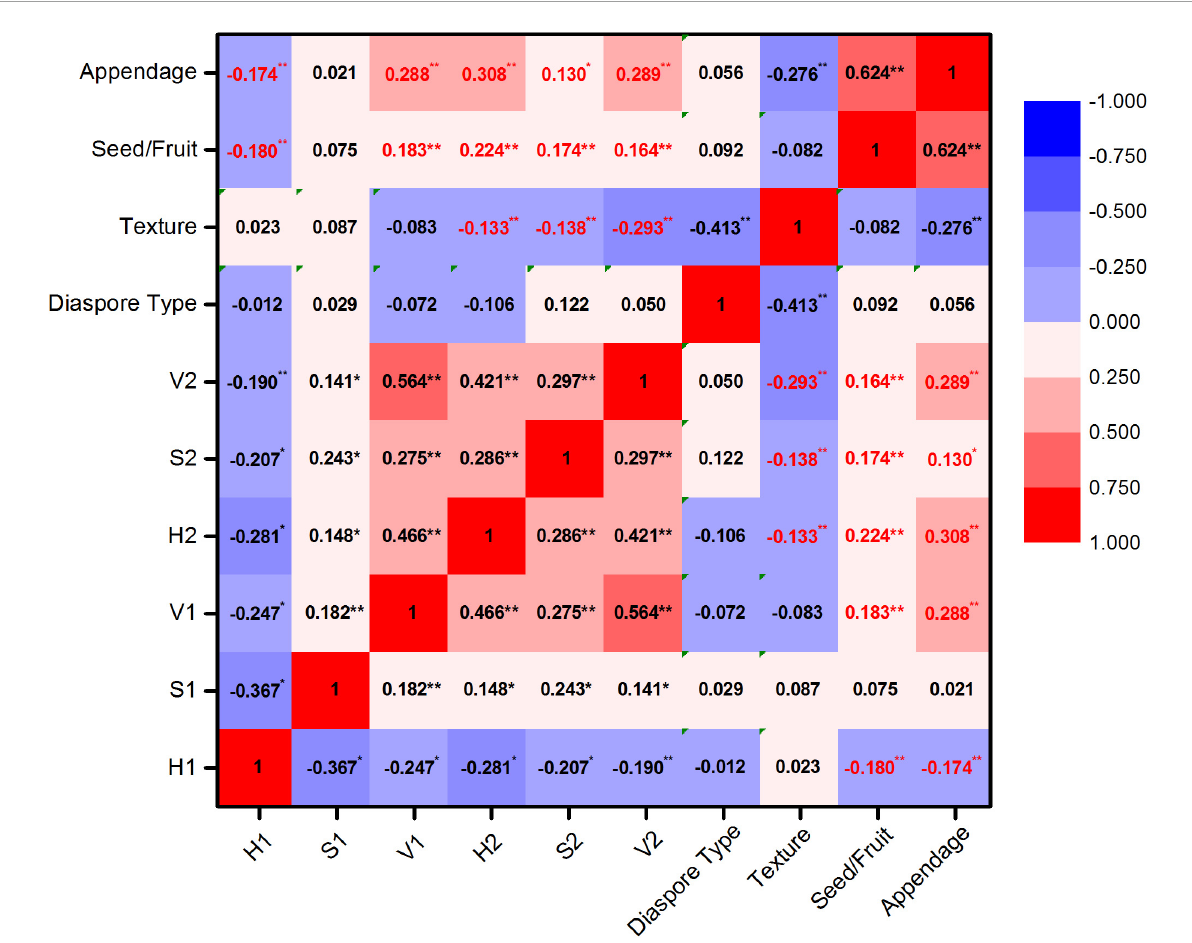
FIGURE2 Correlation analysis of HSV color space and seeds/fruits characters. Hue, saturation, and value of diaspores before staining were represented by H1, S1, and V1 and after staining were represented by H2, S2, and V2. *Significant correlation; **highly significant